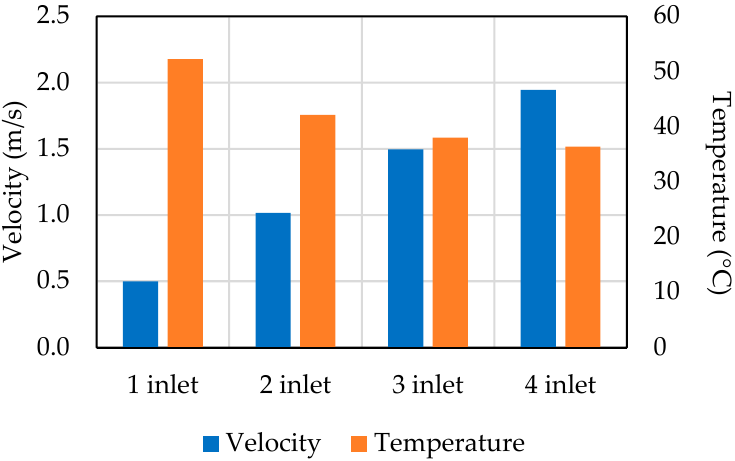
Figure 7. The average values of velocity and temperature vs. the number of inlets.